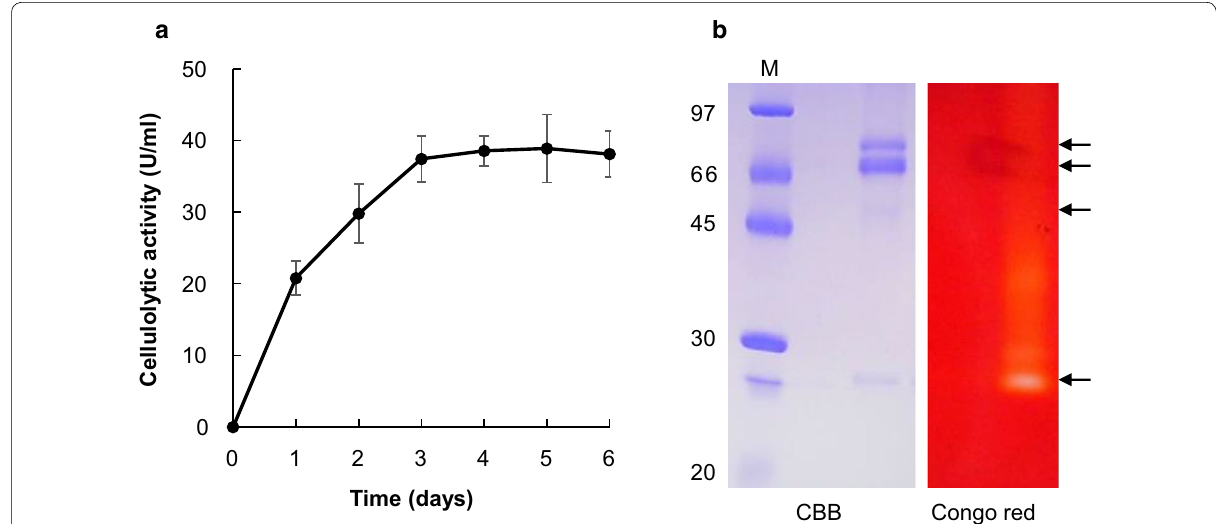
Fig. 3 Time course of cellulase activity in the culture supernatant and zymography analysis of the extracellular proteins. a Cellulolytic activity in culture supernatants from Fusarium spp. strain EI grown with 1.0% CMC for 0–6 days. Data are presented as mean three experiments. b Extracellular proteins produced by Fusarium spp. strain EI during a 3-day incubation resolved on SDS-PAGE (left panel) and zymogram gels (right panel). The detected protein bands on SDS-PAGE are indicated by